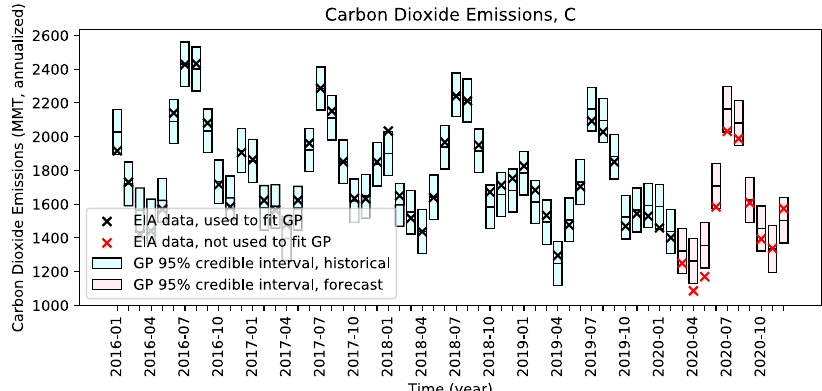
Fig. 1 Expected and observed CO 2 emissions ( C ). Gaussian process (GP) regression is used to provide probabilistic estimates of expected CO 2 emissions in the absence of COVID-19. The GP 95% con fi dence interval describes the range in which CO 2 emissions are expected 95% of the time, as depicted by rectangular bars for each month. The lines in the middle of the bars denote expected values and the “ X ” points denote observed values. Observed CO 2 emissions are outside of (lower than) the 95% con fi dence intervals in only two forecasted months: April and May